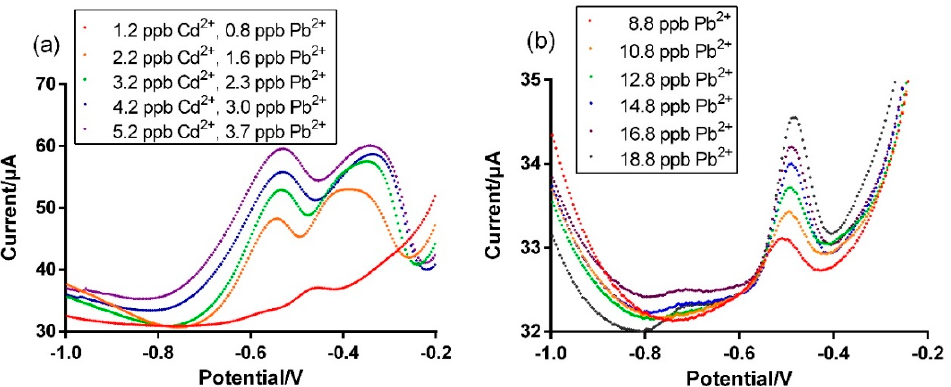
Figure 7. Heavy metal detection using the fabricated Bi-chitosan nanocomposite sensor in ( a ) mining wastewater and ( b ) soil leachate samples. The mining wastewater dilution factor and soil leachate dilution factor are 80 and 50,000, respectively. The spiked data for calibration curves were plotted after baseline subtraction.